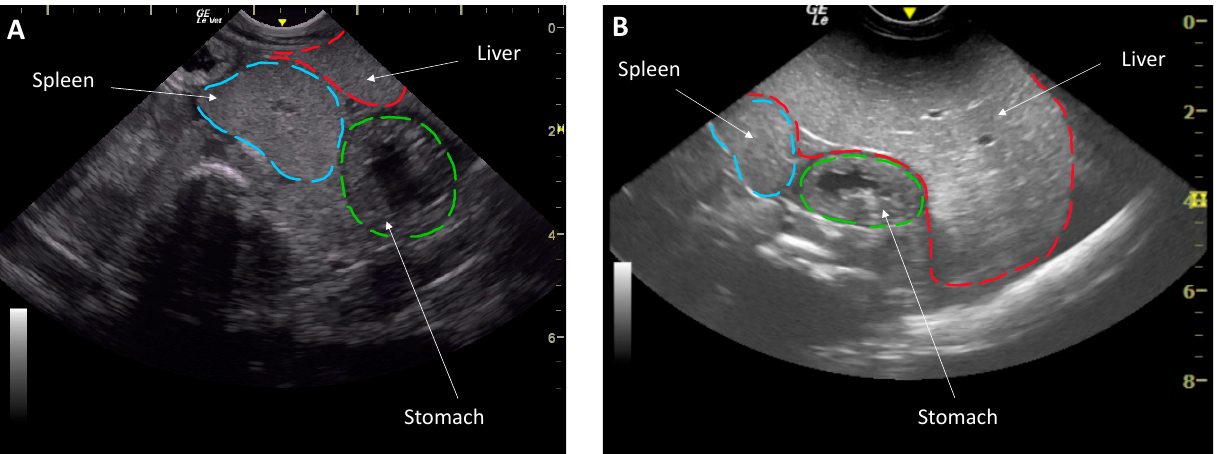
Figure 1. Liver assessment by ultrasonography in a dorsally recumbent male southern stingray ( Hypanus americanus ) of a low body condition in March with a smaller liver ( A ) and an animal in good body condition June ( B ) with a larger liver. Note the depth of the organs illustrated by the gridlines in cm on the right.